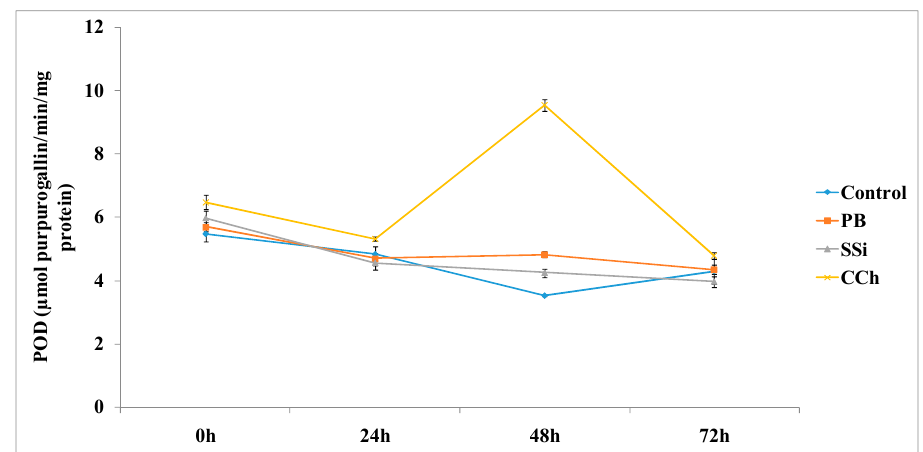
Figure 5. Time course of POD activity ( μ molpurpurogallin/min/mg protein) in extracts from table grape cv. Italia peel treated or not with PB, SSi and CCh. All the values are the means of three replicates ± SE.